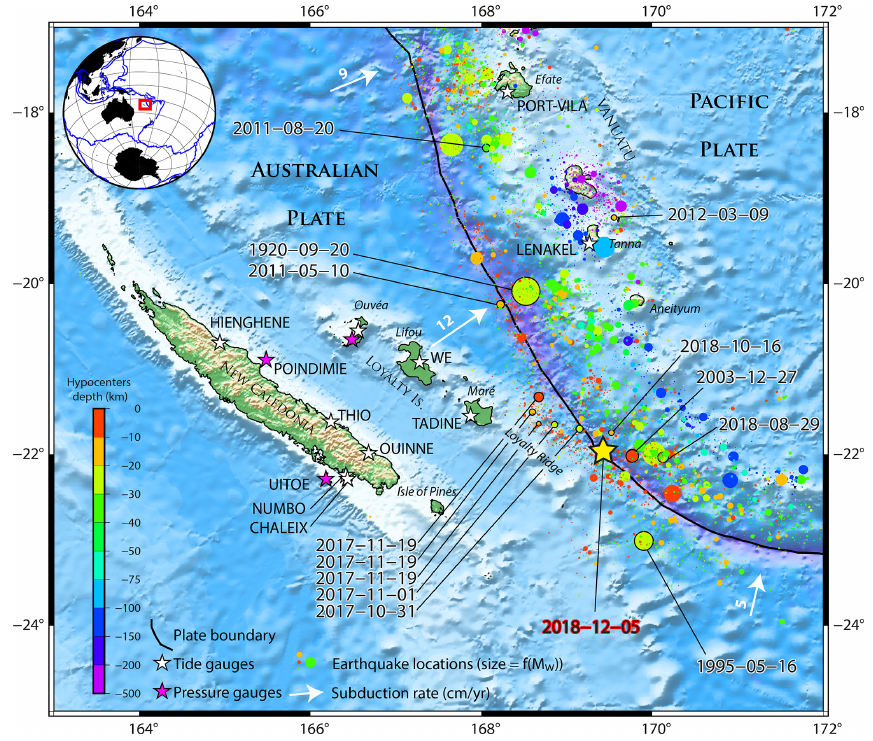
Figure 1. New Caledonia and the south Vanuatu subduction zone. The colored dots represent the seismicity from the USGS database for the period from 1 January 1900 to 24 January 2019, with the size of dots being proportional to the event’s magnitude. Tsunamigenic earthquakes recorded in New Caledonia (Roger et al., 2019b; US Geological Survey, 2019) are highlighted with black-outlined circles and linked to dates. The black line symbolizes the Vanuatu Trench. The white arrows symbolize the subduction directions and rates of the subducting Australian Plate under the Pacific Plate. Tide and pressure gauges able to record tsunami waves are symbolized with white and purple stars respectively. The yellow star indicates the 5 December 2018 earthquake’s epicenter. The study area is located within the red rectangle in the southwestern Pacific